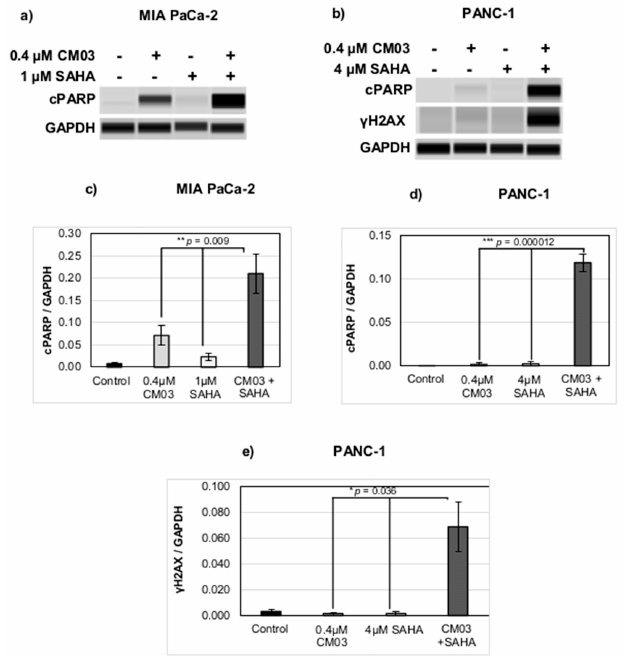
Figure 4. Synergistic induction of apoptosis and DNA damage by the CM03 and SAHA drug combination. ( a , b ) Immunoblot analysis of proteins cPARP and γ -H2AX in PDAC cell lines ( a ) MIA PaCa-2 and ( b ) PANC-1, treated with CM03, SAHA, or in combination at the indicated concentrations. ( c – e ) Quantification of ( c – d ) cleaved PARP (cPARP, apoptosis marker) and ( e ) γ H2AX (DNA damage/DSB marker) normalised to the loading control GAPDH in ( c ) MIA PaCa-2 (cPARP only) and in ( d – e ) PANC-1. Data represent the mean ± SEM of three independent experiments, and the statistical significance was determined using the One-Way ANOVA test, * p < 0.05, ** p < 0.01 and *** p <